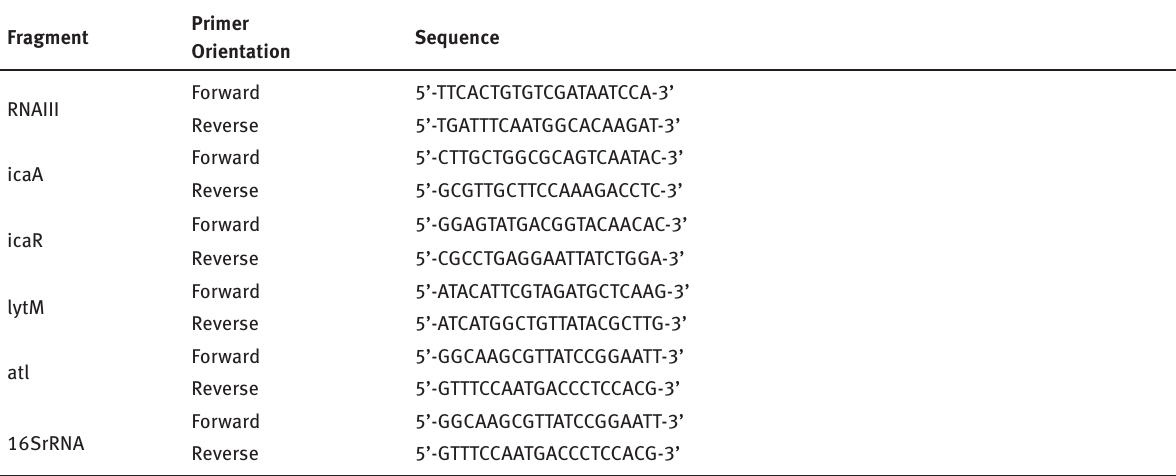
Table 2: Primers used in quantitative real-time PCR experiments